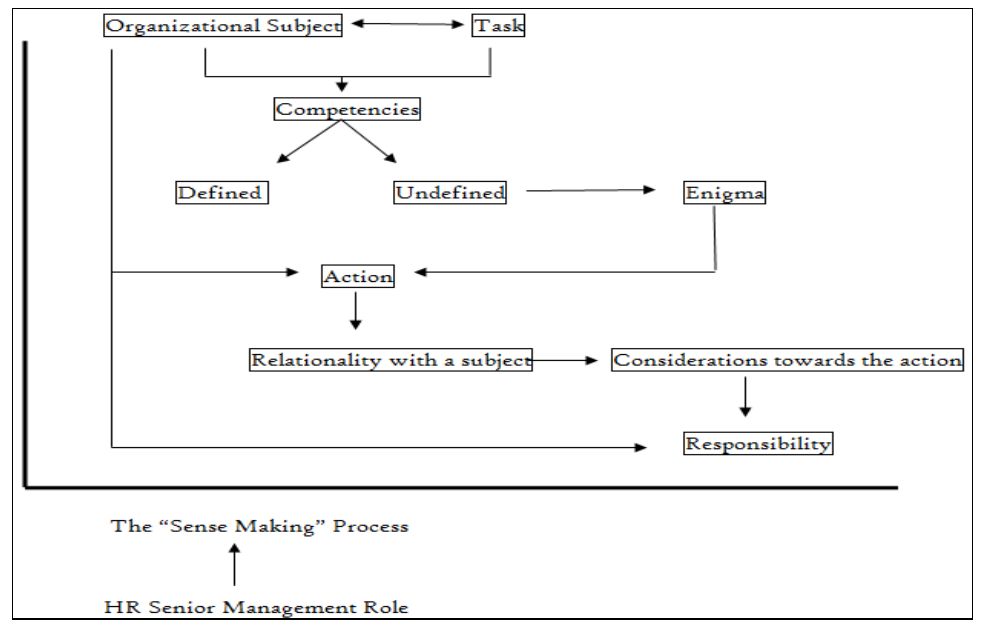
Figure 6: New HR Management